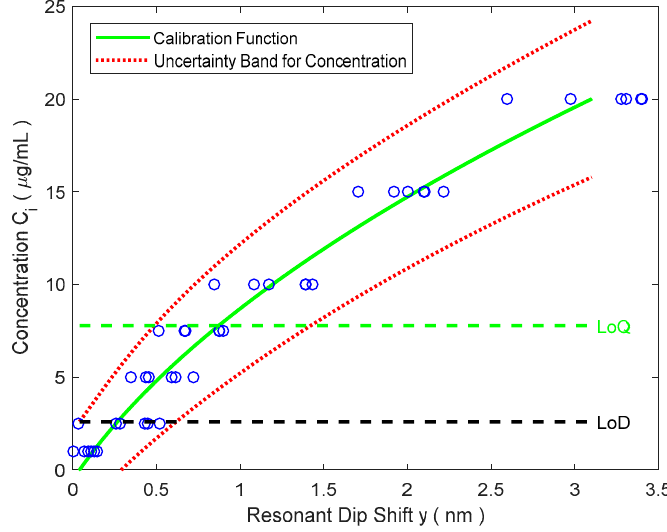
Figure 11. Inverse calibration function and uncertainty bands.